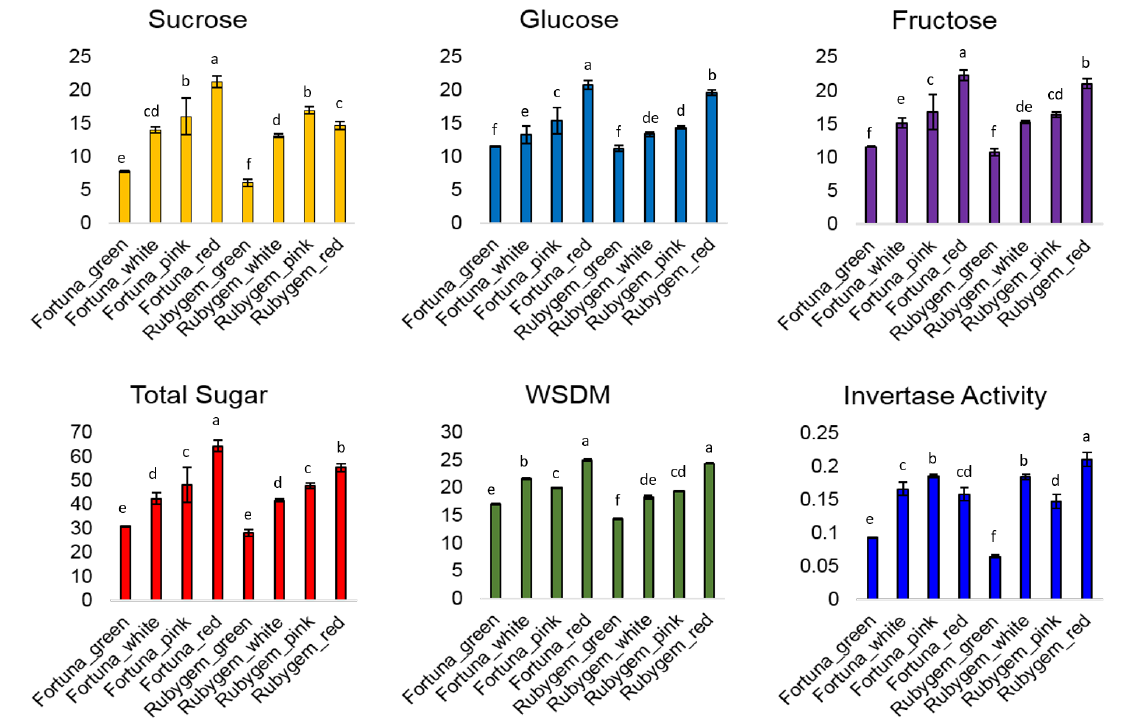
Figure 3. Sugars (mg/100 g fresh weight, mean ± SE of triplicate assays), WSDM (%) and invertase activity (nmol/mg protein, lyophilizer weight) in ‘Rubygem’ and ‘Fortuna’. Different letters on bars indicate statistically significant differences at p < 0.05 level. The activity of the INV gene in both varieties was determined as highest in the green period, gene activity was observed as lowest in the white period. Fortuna’s gene expres- sion level was discovered as lower than Rubygem ’ s; however, the INV gene expression level was found to be similar in both varieties. In addition, a negative correlation was observed between INV gene expression level and INV activity and sugar content in fruits at four different stages of development (Figure 4).